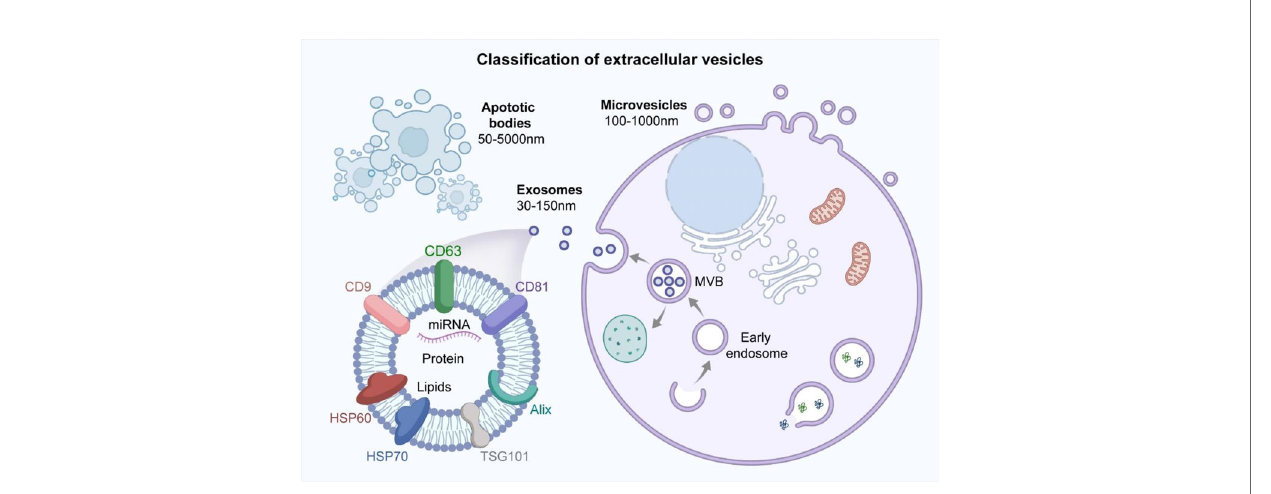
endosomes further develop into multivesicular bodies (MVBs) that contain intracellular vesicles. The MVBs fuse with the lysosomal membrane or cell membrane and degrade, releasing the contents (i.e., exosomes) into the extracellular environment through exocytosis (95, 96). The process of exosome formation is